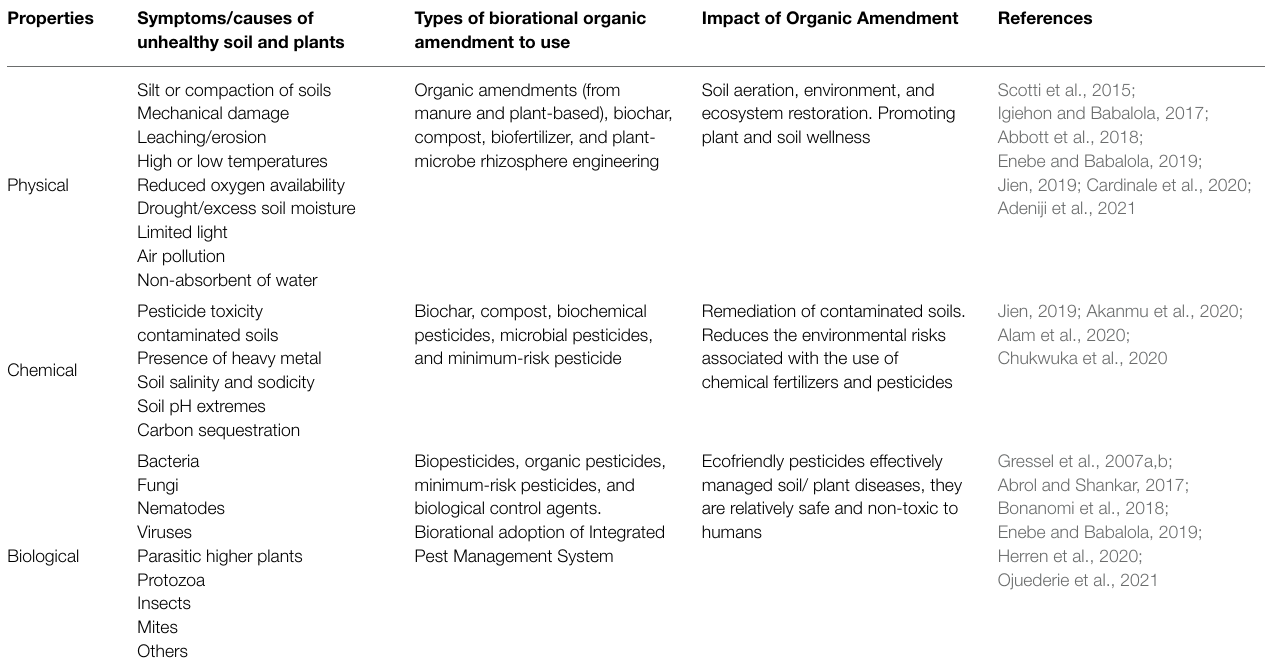
TABLE 1 | Biorational management of unhealthy soil and